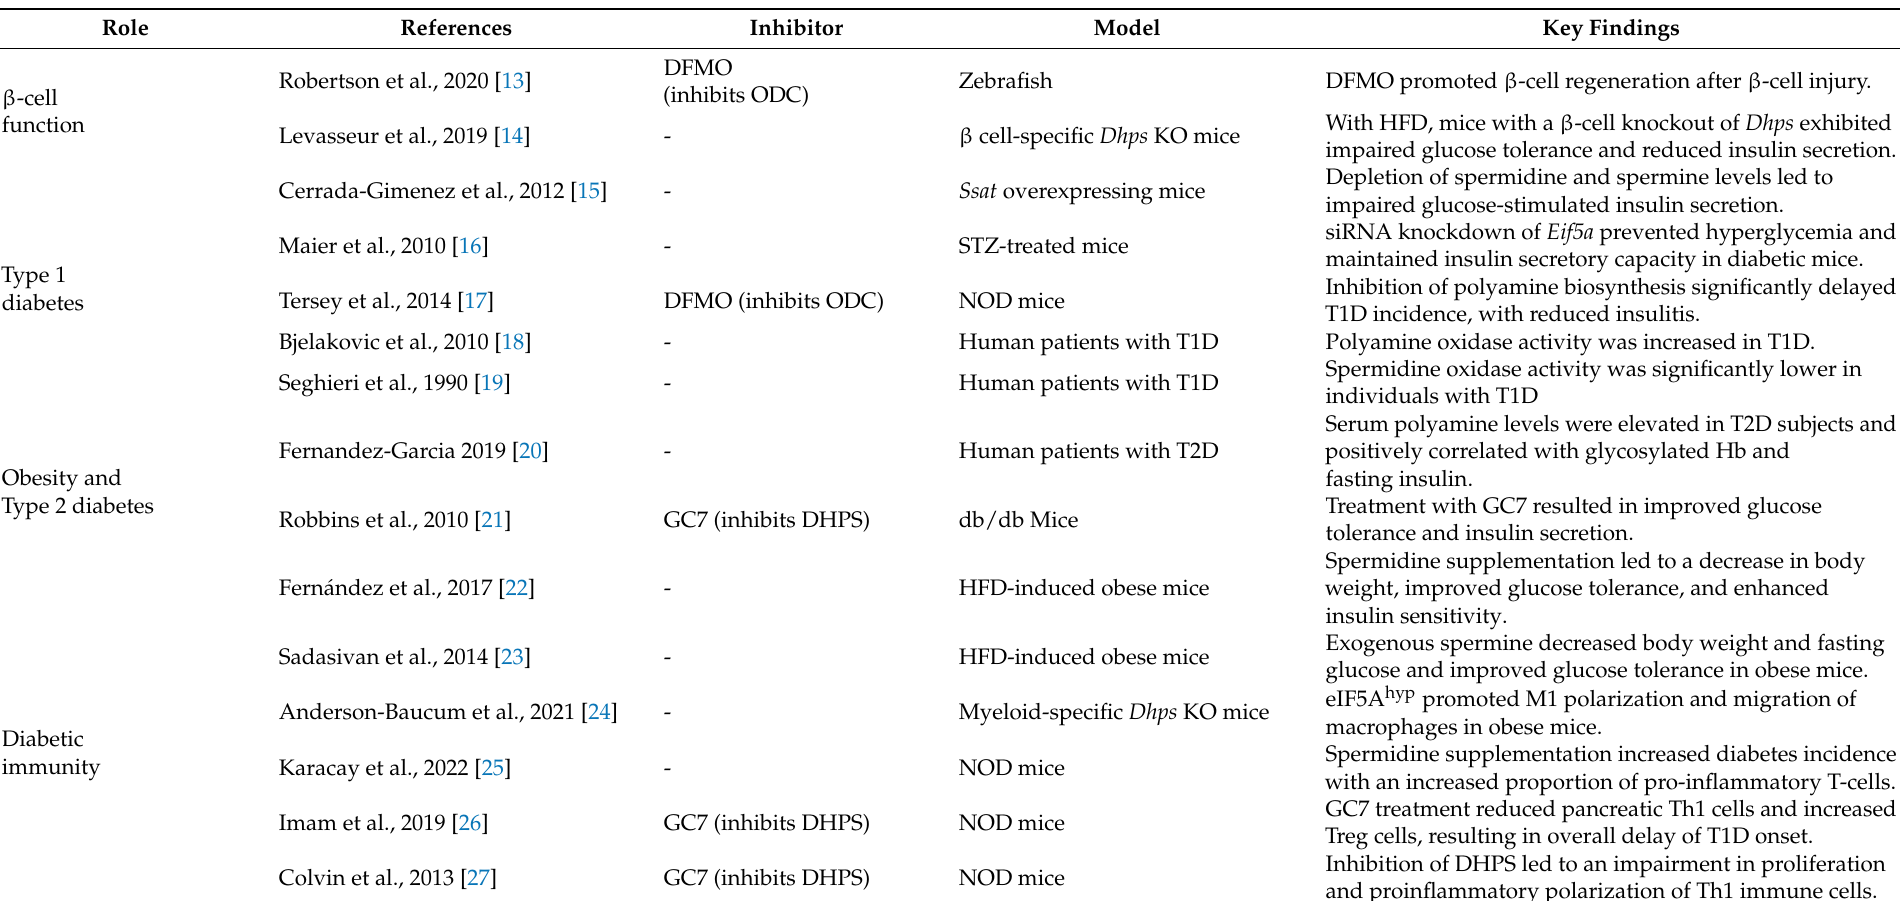
Table 1. Summary of studies on the role of the Polyamines-Hypusine circuit in diabetes. DFMO—difluoromethylornithine;